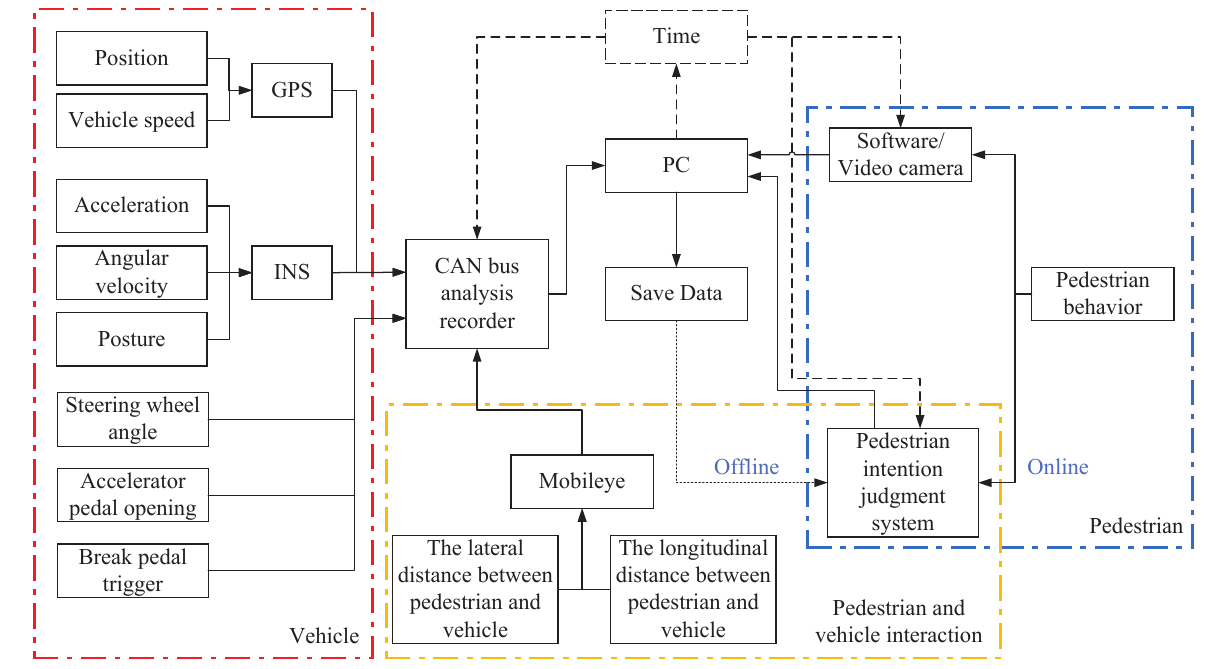
Figure 3. Block diagram of data collection.